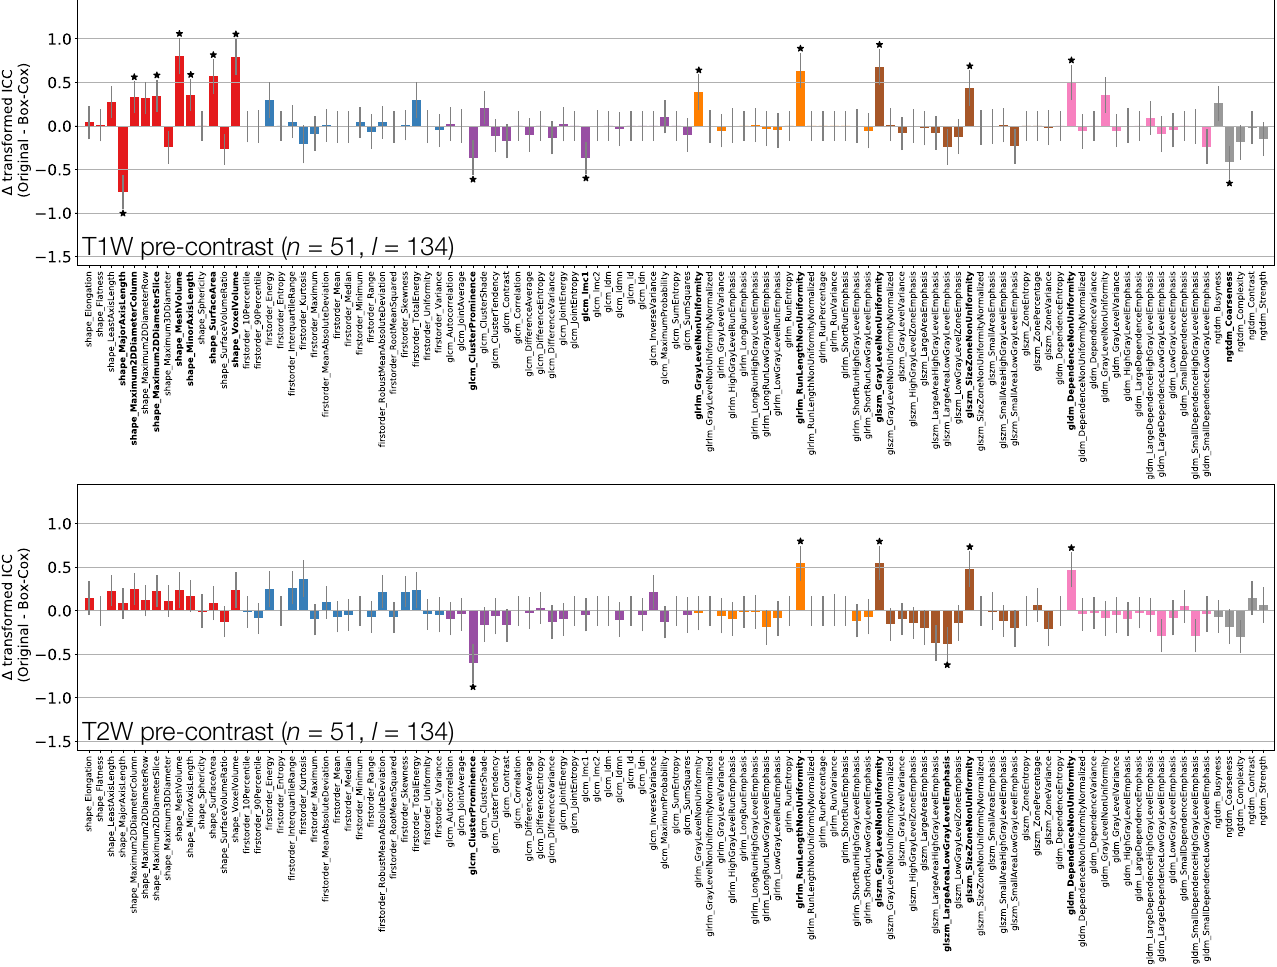
Figure 3. Effect of applying Box–Cox transformations to feature distributions, for T 1 W (top) and T 2 W (bottom) pre-contrast images. Bars represent the difference in ICC point estimates (after applying Fisher’s Z -transformation), and error bars represent 95% CIs. Features are colour coded according to their class: Shape (red), First Order (blue), GLCM (purple), GLRLM (orange), GLSZM (brown), GLDM (pink), and NGTDM (grey). Black stars and bold fonts indicate features where ICCs from original and Box–Cox transformed data are significantly